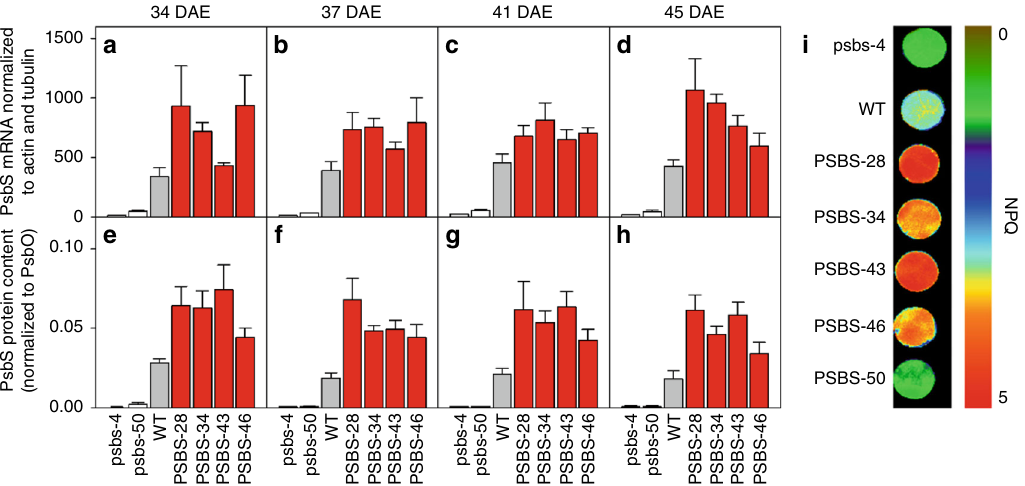
Fig. 2 PsbS expression and photoprotection in Nicotiana tabacum plants grown under fi eld conditions. a – d PsbS mRNA levels and e – h PsbS protein levels in several tobacco genotypes with modi fi ed PsbS expression levels as well as wild-type (WT) tobacco at four time points during the fi eld experiment (DAE = days after emergence). i Representative levels of NPQ for each genotype determined on leaf discs. All genotype means were signi fi cantly different from WT (Dunnett ’ s two-way test; P ≤ 0.008 for mRNA; P ≤ 0.001 for protein). Error bars indicate s.e.m. ( n = 4 biological